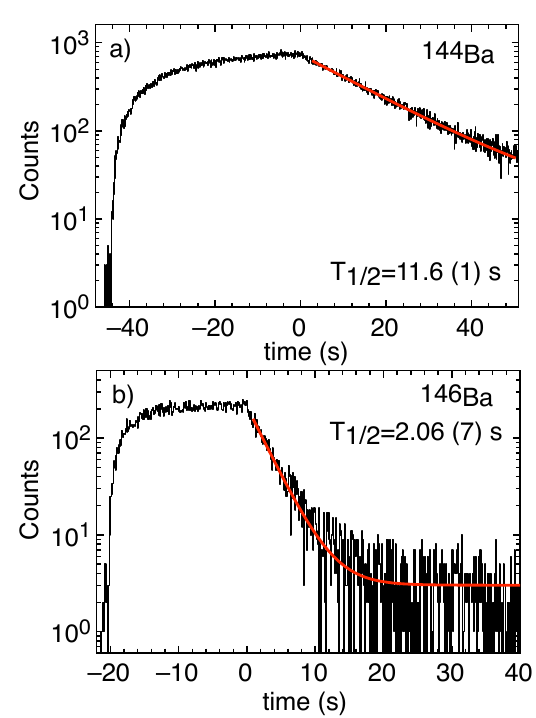
Figure 4. Time spectra produced by gating on: (a) - sum of 104-, 157-, 173- and 388-keV γ rays following the 144 Ba decay; (b) - sum of 121-, 141-, 197-, 232- and 251-keV γ rays following the 146 Ba